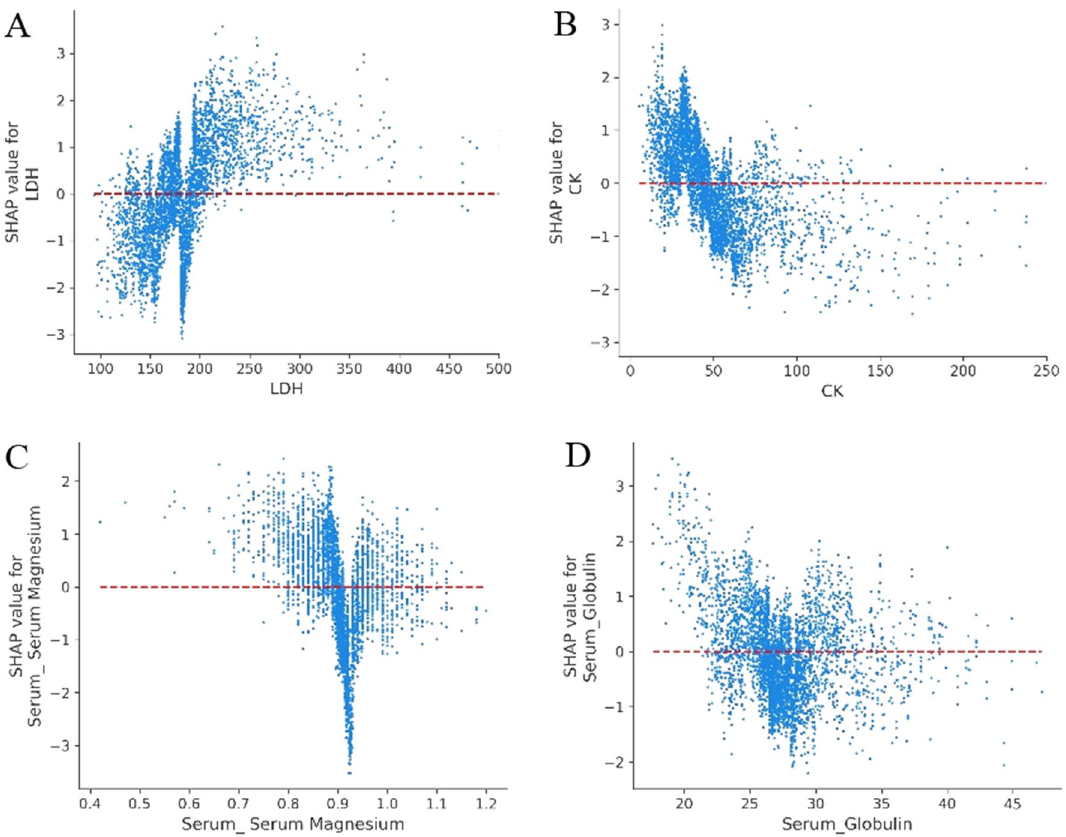
Figure 8. Partial SHAP dependence plots for blood biochemistry. ( A ) LDH. ( B ) CK. ( C ) Magnesium. ( D ) Globulin. LDH: lactate dehydrogenase. CK: Creatine kinase.